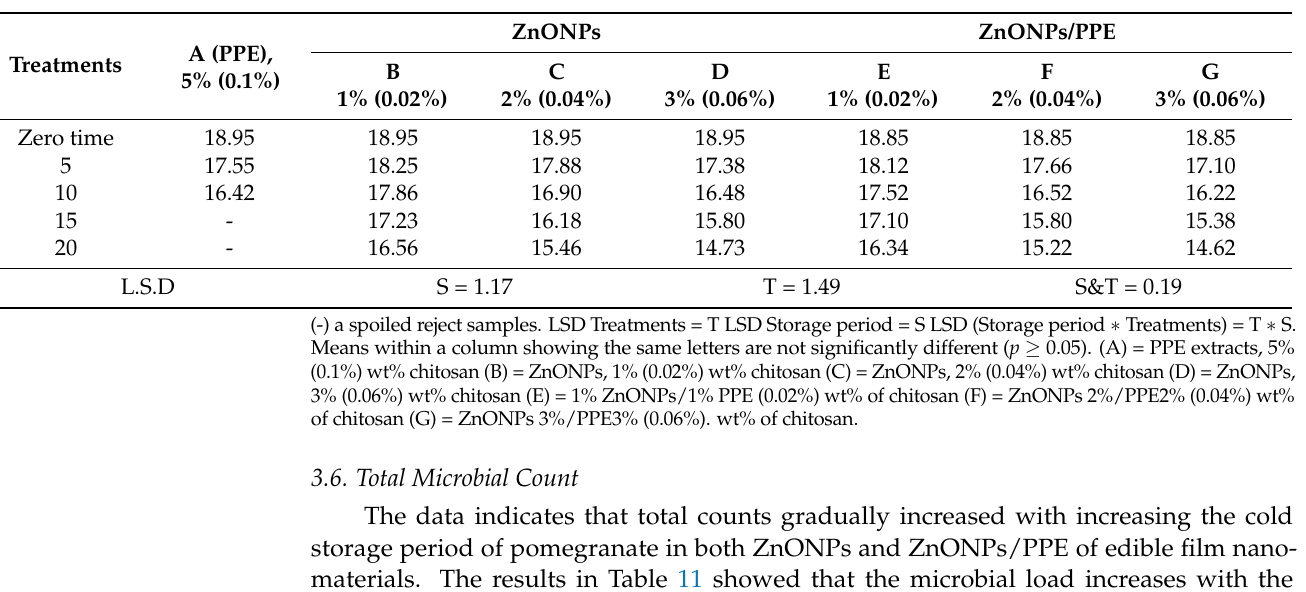
Table 10. Effect of edible film and coatings on anthocyanin% of manfalouty pomegranate during storage at 2 ◦